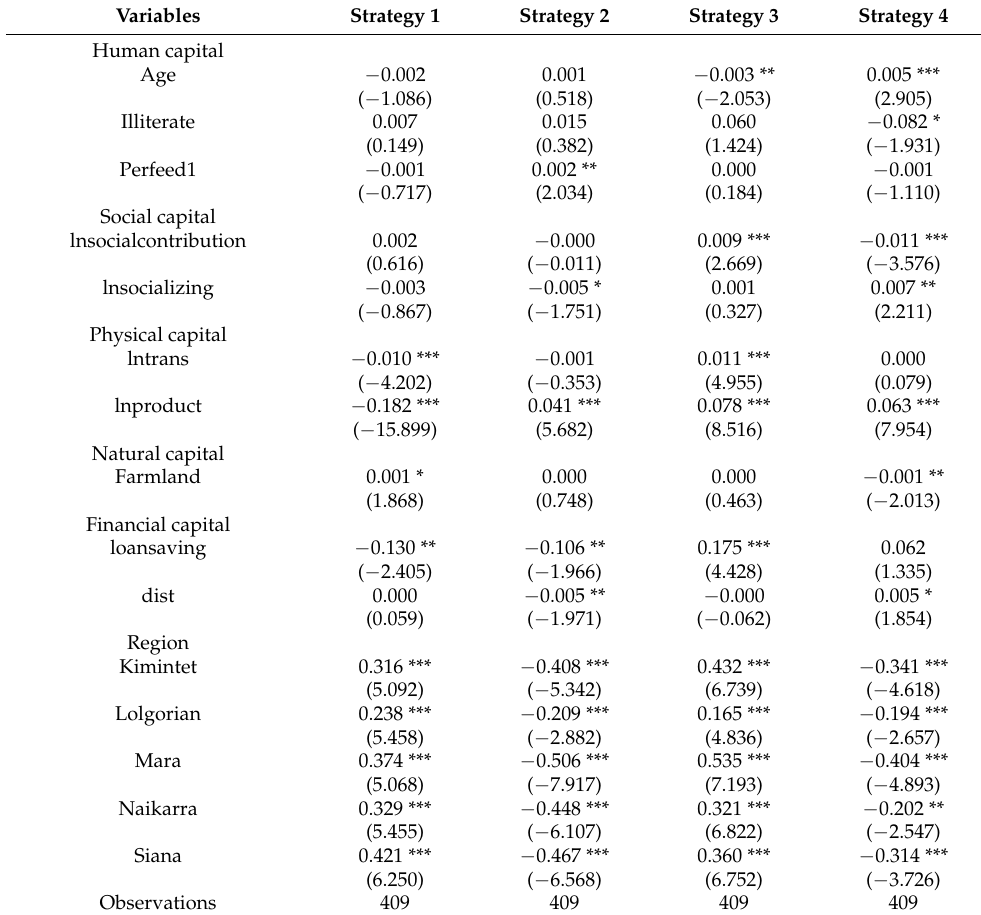
Table 4. Marginal effects of different